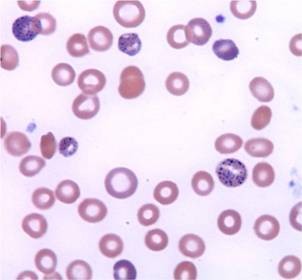
Wright-Giemsa stained smear of peripheral blood. Coarse basophilic stippling of the erythrocytes results from the poisoning of the 5' nucleotidase normally responsible for degrading RNA. Magnification is 1000x.